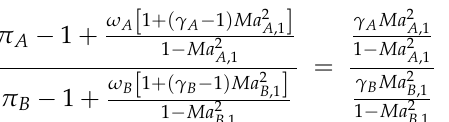
Table 1. NACA65-K48-Basic parameters [20].